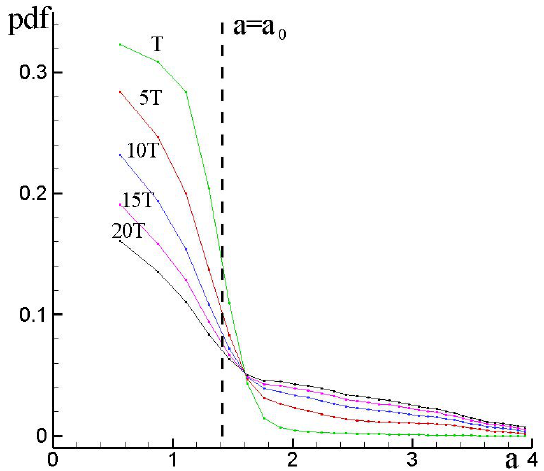
Fig. 7. The part of markers which are located outside the vortex at instant N T · T . The green and red curves correspond to the perturbed and steady states,